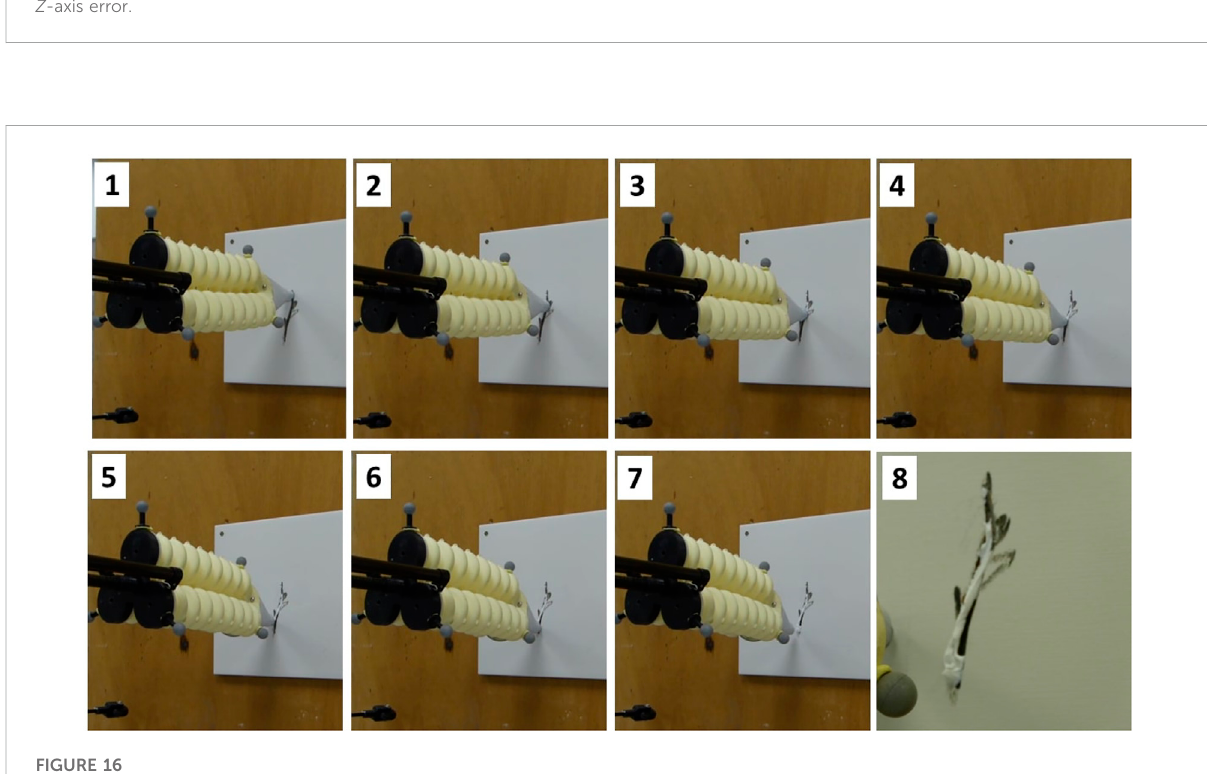
FIGURE 16 Repair steps for crack